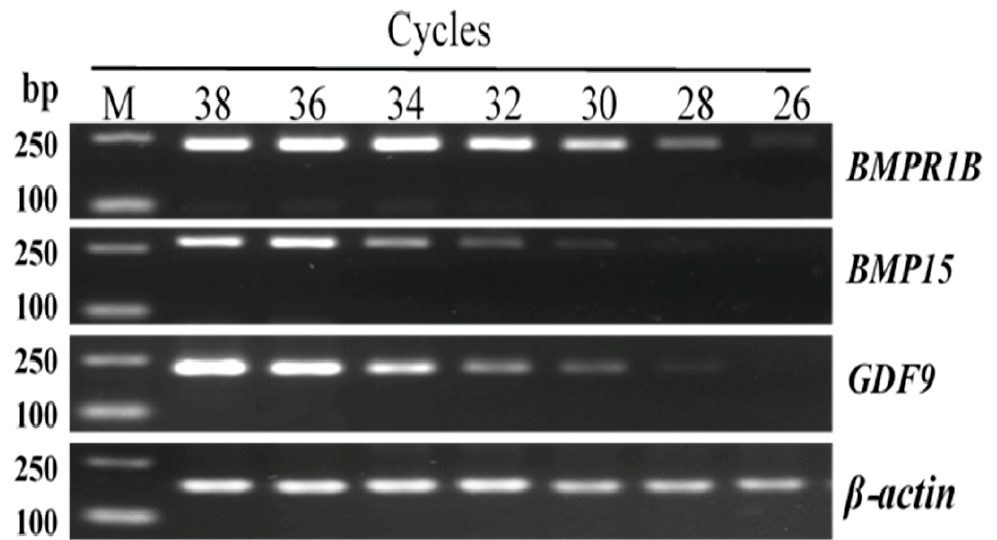
Figure 1. Amplification results of BMPR1B, BMP15 , and GDF9 in different reaction cycles. M: DL2000 DNA marker.